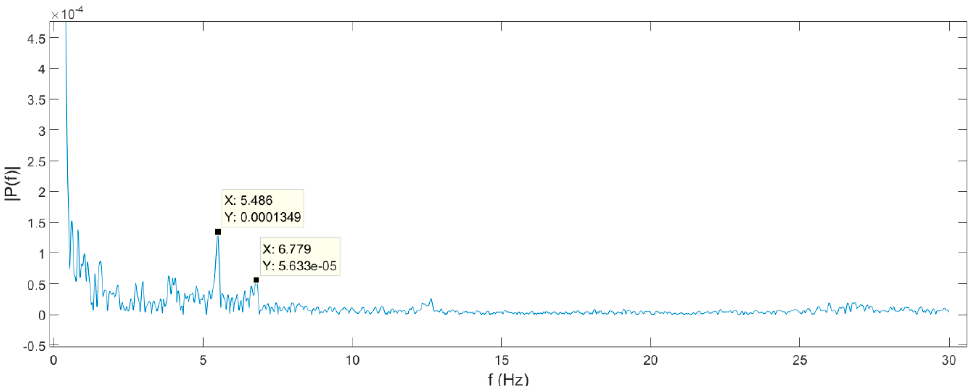
Figure 16. Amplitude spectrum of vertical component and detected first and second frequencies by IATS prototype (excitation by train passing at 40 km/h).